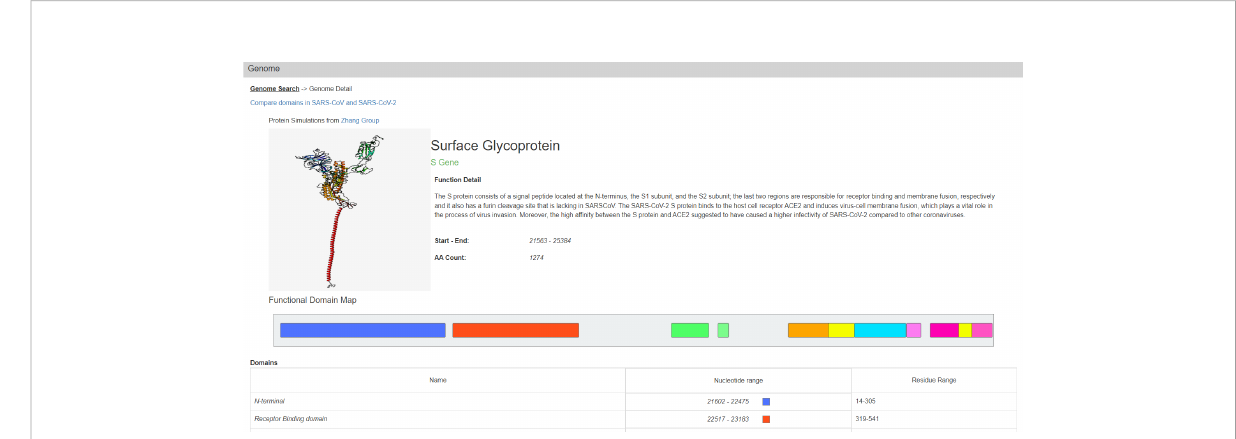
FIGURE 2 The Genome Detail page of the S protein. Data presented includes a protein structure simulation, functional detail, coordinates for start and end, domain map/ranges, and more. This page links to the SARS-CoV vs SARS-CoV-2 comparison page and reference sequences for the gene and